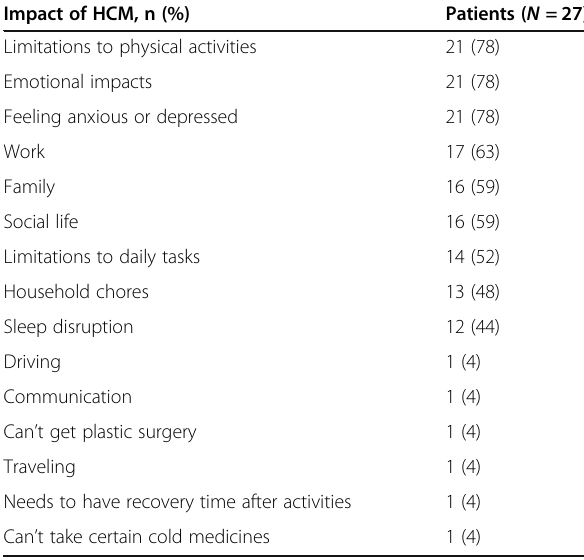
Table 5 Impacts of the disease most frequently identified by patients during the concept elicitation interviews Impact of HCM, n